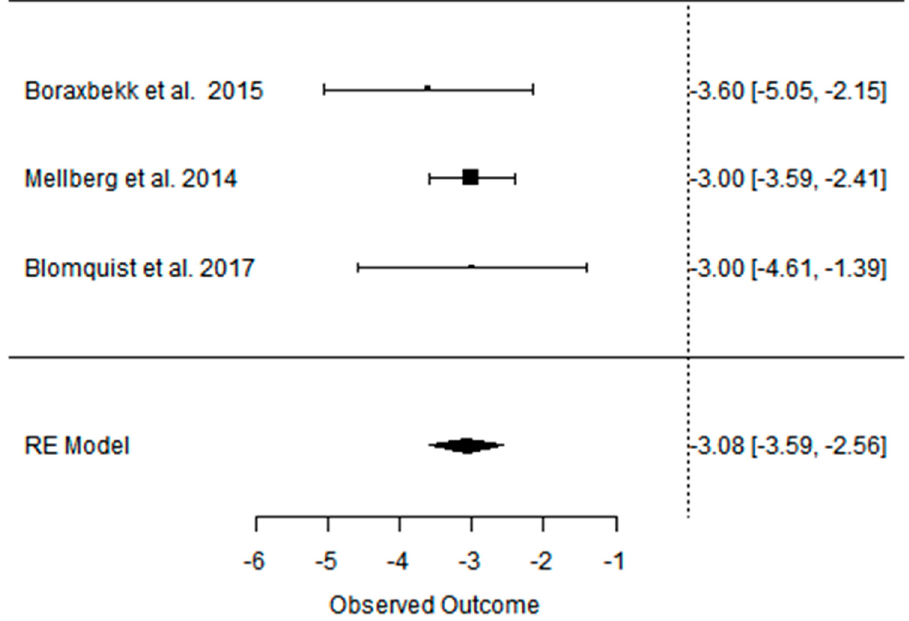
Figure A5. Forest plot of the effect of PD on BMI in the short term (weighted mean difference).